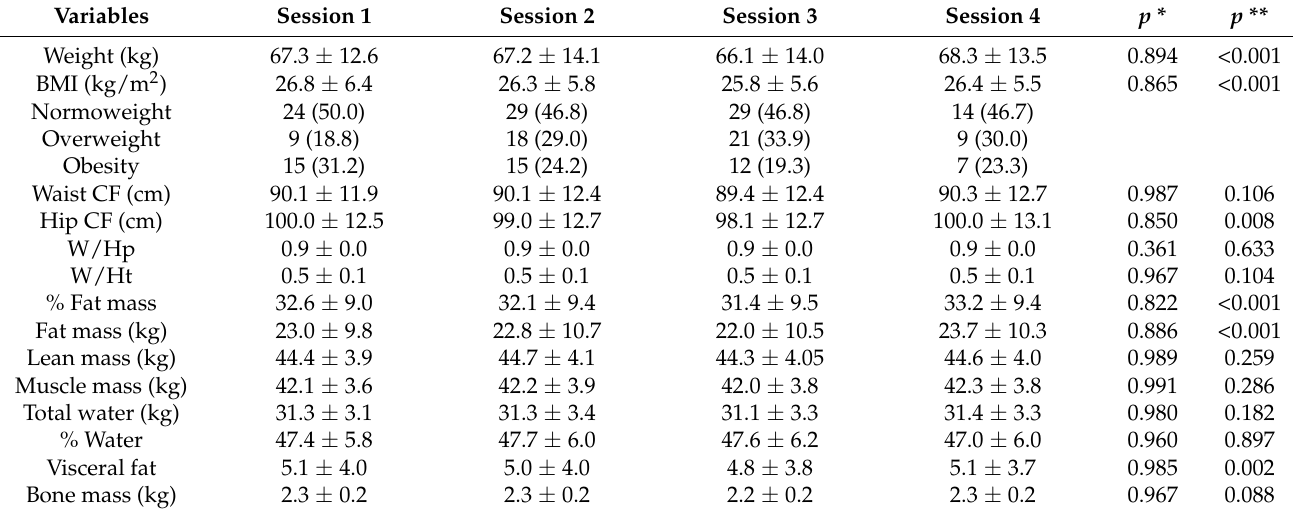
Table 2. Anthropometric measurements and bioimpedance.